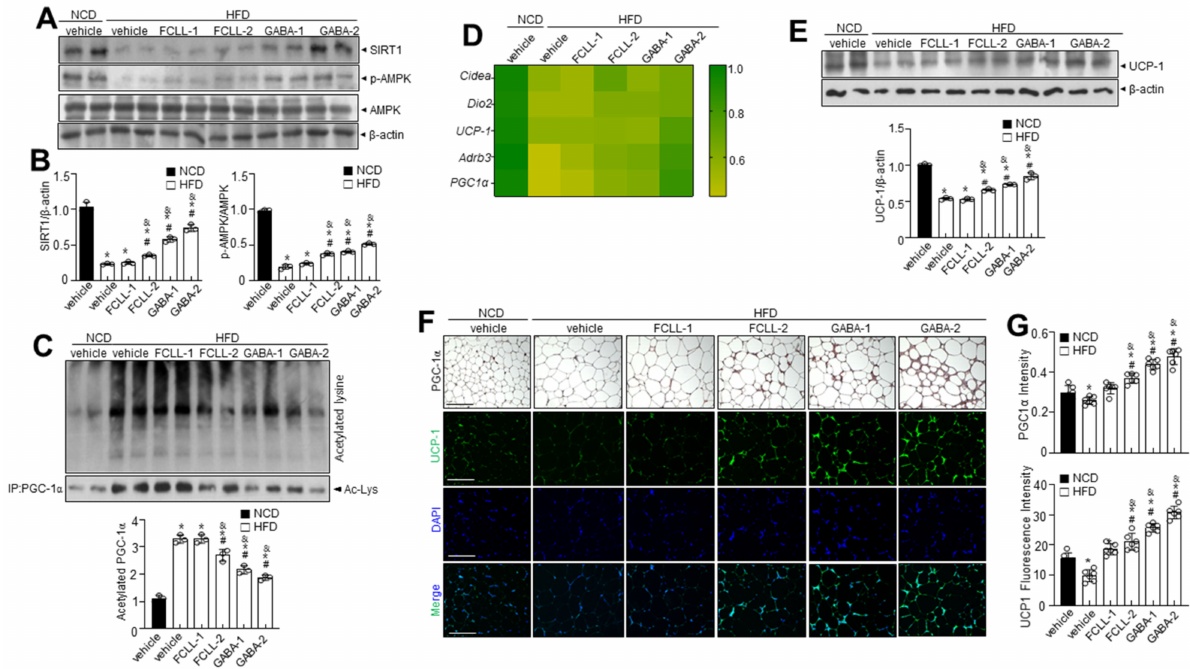
Figure 8. GABA and fermented Curcuma longa L. extract enriched with GABA promote thermogenic program in brown adipose tissue. Mice received vehicle or GABA and fermented Curcuma longa L. extract enriched with GABA (1 or 2 g/kg) once daily for 14 weeks by oral gavage. ( A ) Immunoblotting of SIRT1, p-AMPK, AMPK, and β -actin in BAT and ( B ) respective quantitative analysis of protein expression. ( C ) Immunoprecipitation using an antibody against PGC-1 α to evaluate acetylation levels. ( D ) Heatmap depicting mRNA expression of brown fat-specific genes. ( E ) Immunoblotting of UCP1 and β -actin in the BAT and quantitative analysis of protein expressions. ( F , G ) Representative images of the PGC-1 α immunohistochemical staining or the immunofluorescence staining of UCP1 on BAT sections and respective quantification of fluorescence intensity. Data are presented as mean ± SEM ( n = 8, * p < 0.05 vs. NCD + vehicle, & p < 0.05 vs. HFD + FCCL-1, # p < 0.05 vs. HFD + vehicle). BAT, brown adipose tissue, NCD, normal chow diet; HFD, high-fat diet; FCLL-1 and FCLL-2, HFD fed mice received 1 and 2 g/kg fermented Curcuma Longa L. enriched with GABA (FCLL-GABA), respectively; GABA-1 and GABA-2, HFD fed mice receiving 1 and 2 g/kg GABA were assigned,